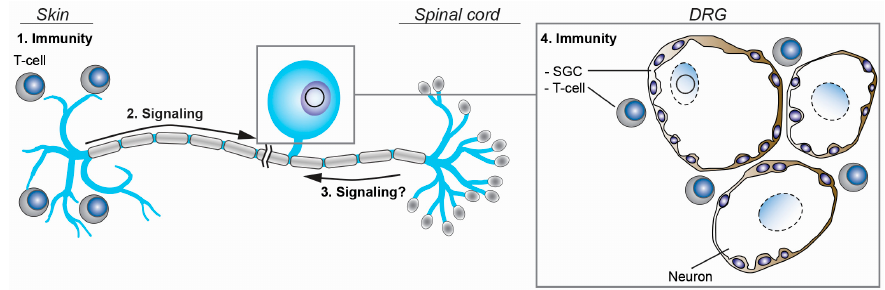
Figure 4. Schematic representation of the regulation of VZV latency and reactivation. The activation of neuronal signaling pathways in response to stimuli at the periphery (2) and possibly, within the spinal cord (3) may induce VZV reactivation. At the same time, adaptive T-cell-mediated immune responses in skin (1) and ganglia (4), and the local ganglionic innate immunity provided by neuron-interacting satellite glial cells (SGC) are believed to prevent symptomatic VZV